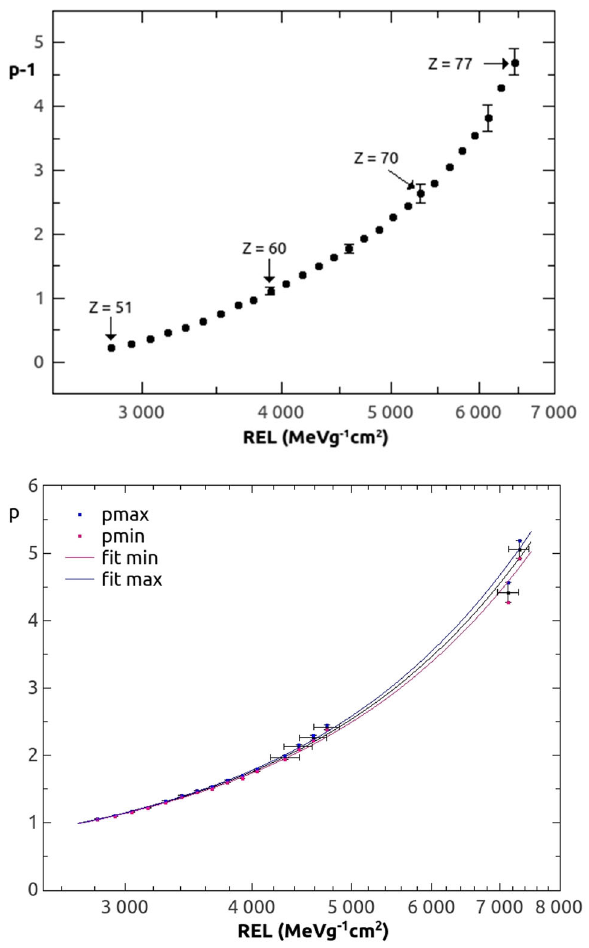
Fig. 10 Reduced etch-rate ( p ) versus REL for Makrofol exposed to relativistic Lead and Xenon ion beams: (top) detectors etched in soft conditions;(bottom) detectors etched in strong conditions. The upper and low curves are drawn through the ± 1 σ value of the error on each p value, where the error bars represent a convolution of the statistical and systematic errors on each